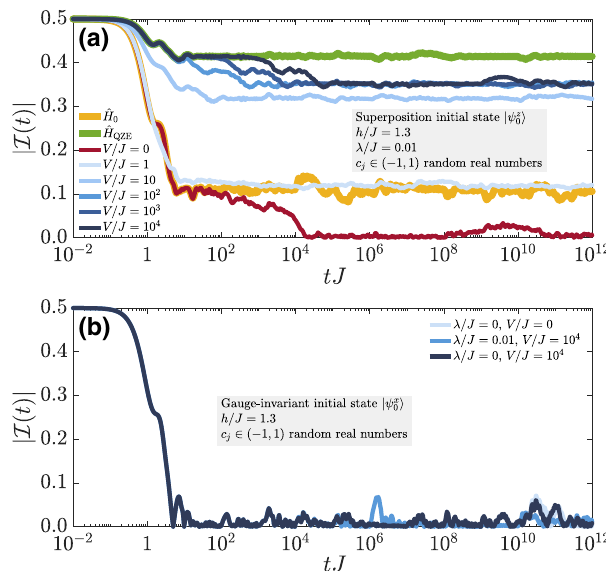
FIG. 7. LPG protection with a translation-noninvariant sequence c j ∈ ( − 1, 1 ) of random real numbers. (a) When (cid:3) , the LPG pro- starting in the superposition initial state | ψ z 0 tection at sufficiently large V leads to localized dynamics that is well reproduced by the same effective gauge theory (cid:2) ˆ P ˆ H = ( ˆ H + λ ˆ H ) ˆ P QZE 0 1 w w that emerges in the case of w a translation invariant c j , up to a timescale polynomial in V . However, the renormalized gauge theory that emerges after this timescale, which conserves only the Z 2 gauge symmetry, persists over all accessible evolution times in exact diagonalization, which is not the case when c j is translation invariant, where the imbalance eventually thermalizes to zero; see Fig. 4(b). (b) (cid:3) , LPG protection Starting in the gauge-invariant initial state | ψ x 0 with a random c j does not protect localized behavior regardless of λ and V .